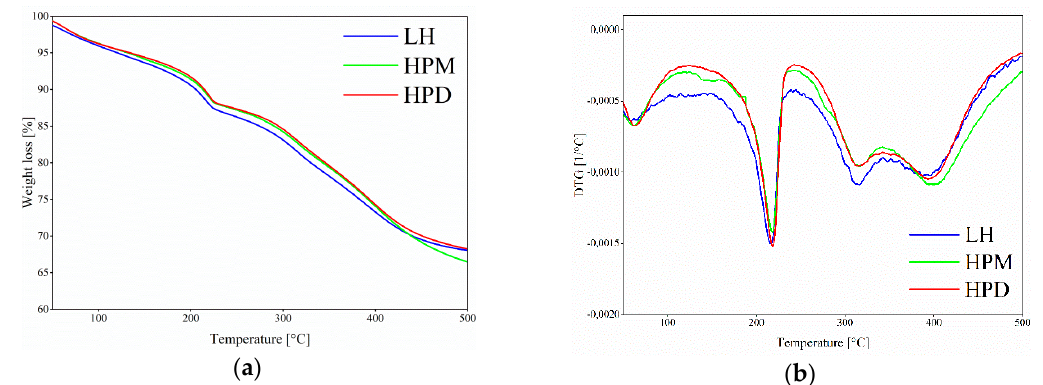
Figure 6. Thermal analysis of studied hybrid pigments: ( a ) thermogravimetric (TG) and ( b ) the derivative thermogravimetric (DTG) curves.